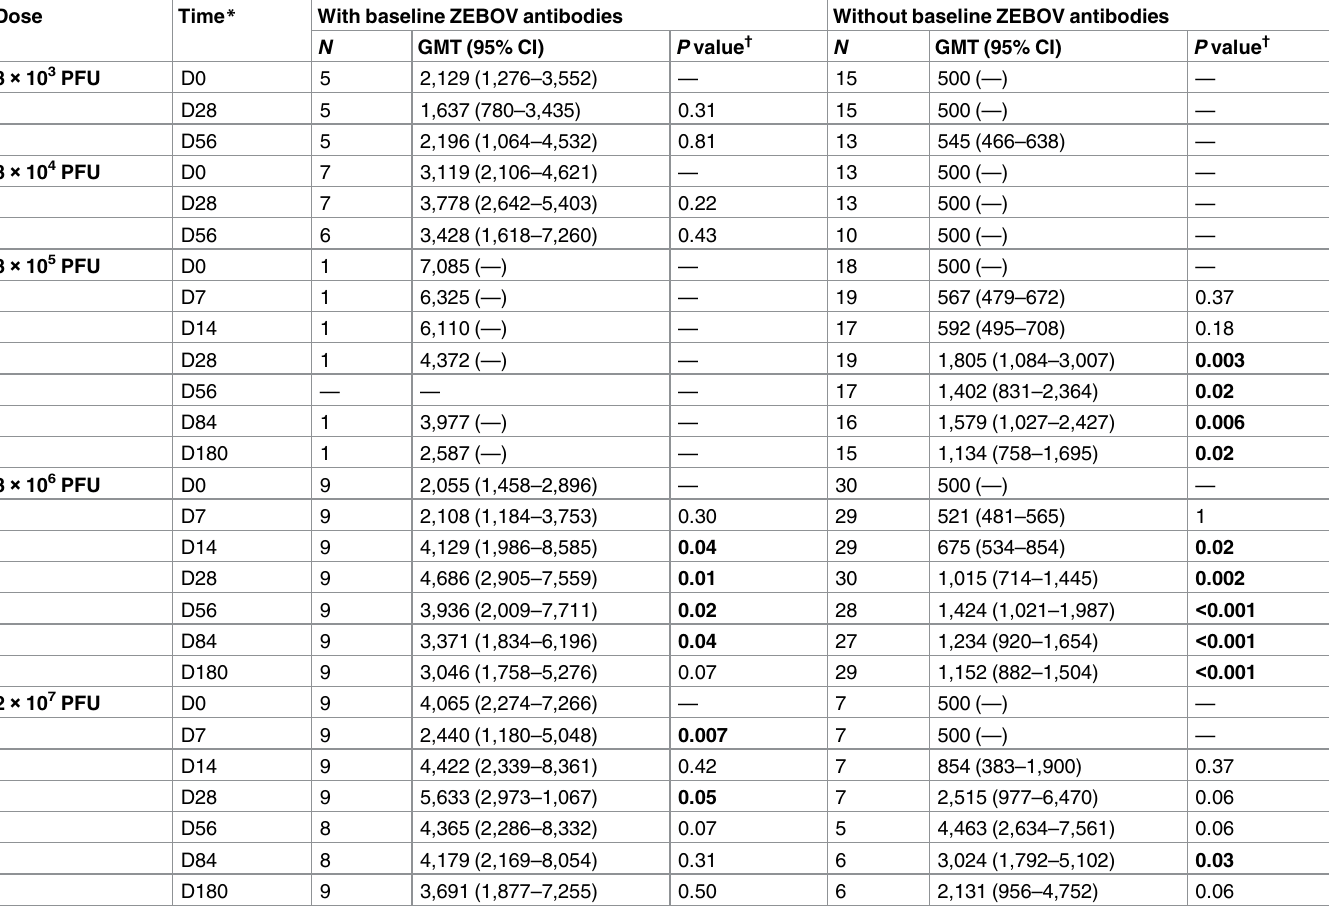
Table 6. Geometric mean titres of ZEBOV antibodies in adults by baseline antibody status measuredby whole-virion ELISA. Dose Time * With baseline ZEBOV